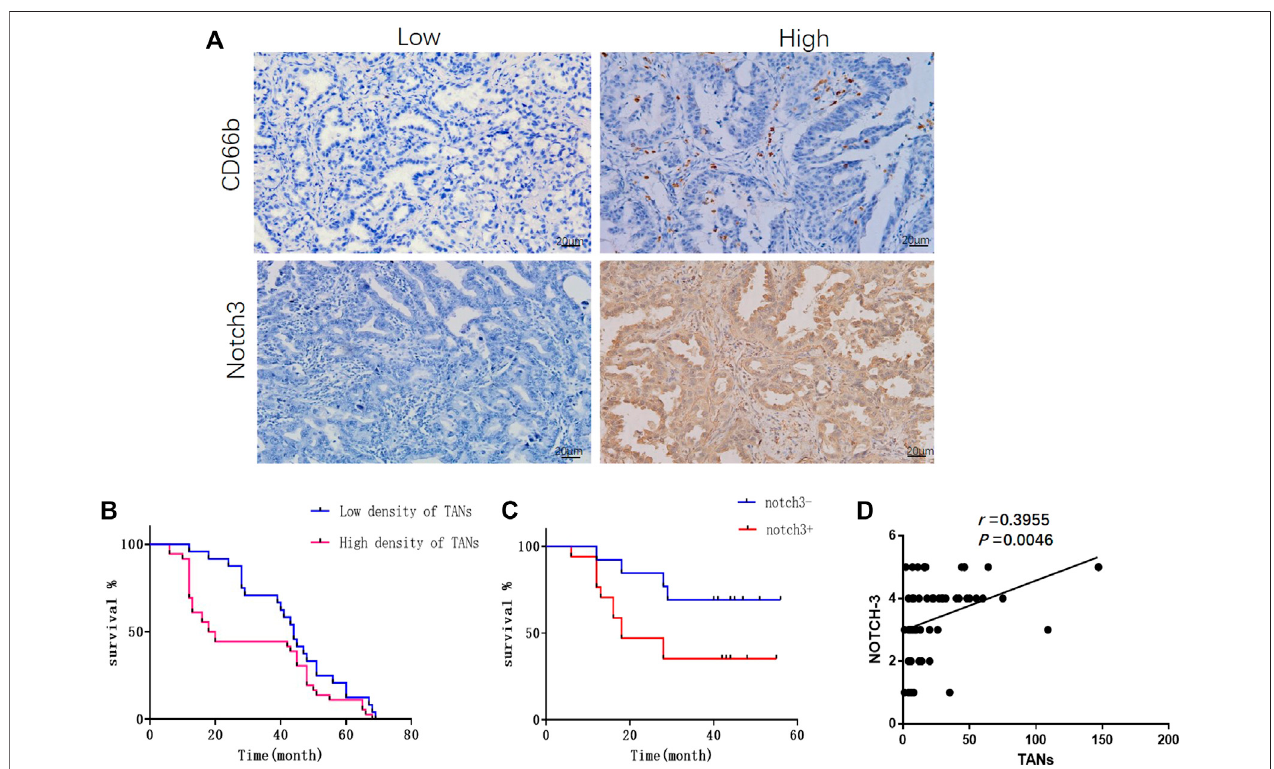
FIGURE 1 | The in fi ltration of TANs and the expression of Notch3 in lung adenocarcinoma were associated with poor prognosis. (A) Representative images for immunohistochemical staining of CD66b and Notch3 in lung adenocarcinoma. (B) Survival analysis showed that the density of TANs was negatively correlated with disease-free survival (DFS). (C) Survival analysis showed that the expression of Notch3 was negatively correlated to DFS. (D) The correlation between the density of TANs and the expression of Notch3 in lung